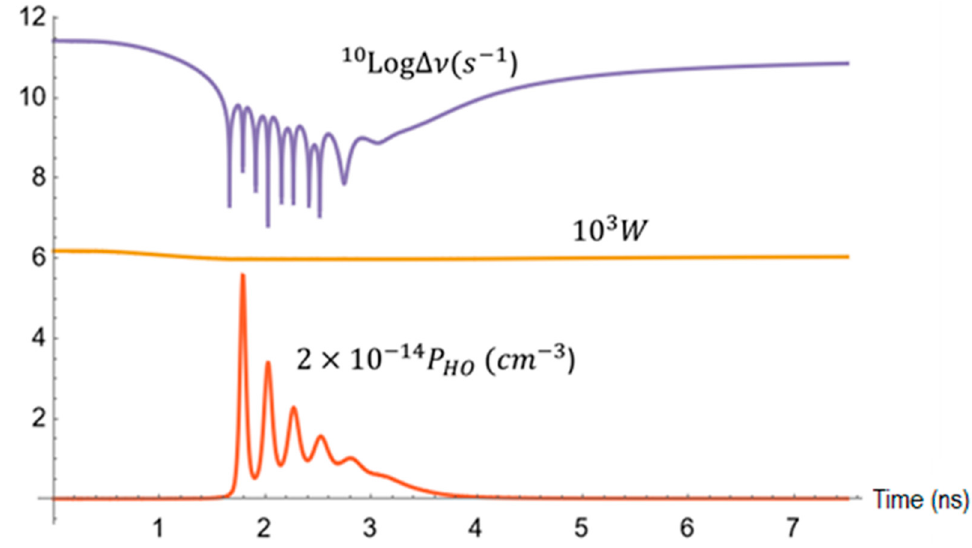
Figure 6. Time evolutions of the photon density (red), instantaneous linewidth (purple) and reabsorption factor (yellow) for the case of Figure 5c, i.e., Q = 3000 and J = 2 kA/cm 2 .